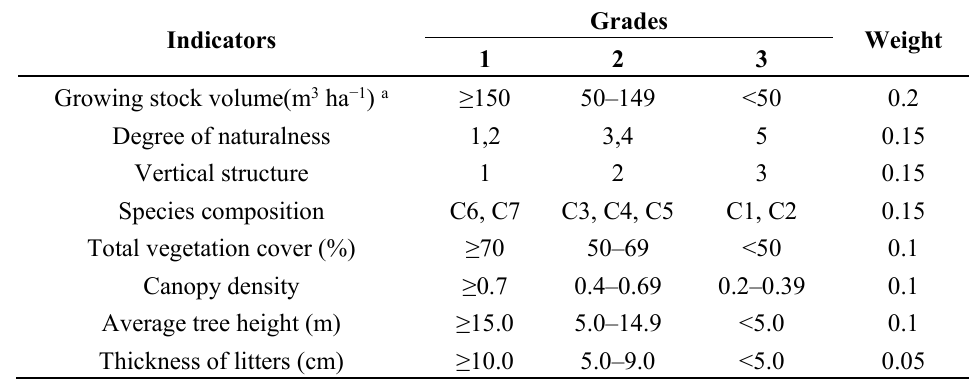
Table 3. Grades and weights for indicators of forest ecological functions in China [20].